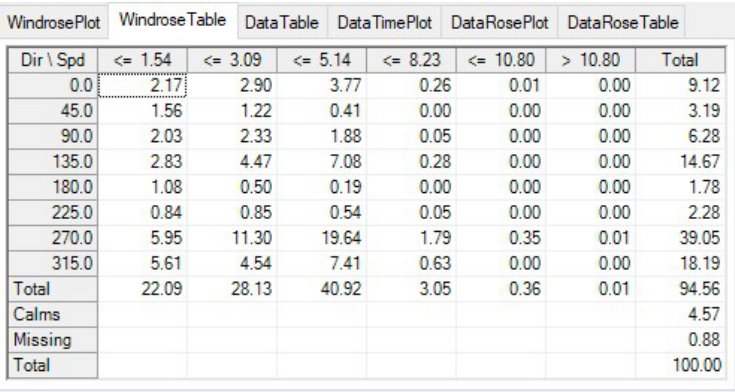
Figure 9. Speed frequency wind data .